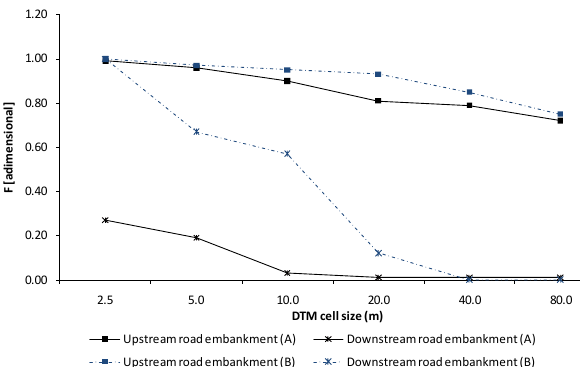
Figure 10. Comparison of F values, for different DTM grid size for automatically produced DTM (A) and modified ones (B) 3.1.3 Simulation time : The simulation time using large cells for hydro-morphological and hydraulic simulations change drastically, according to the grid